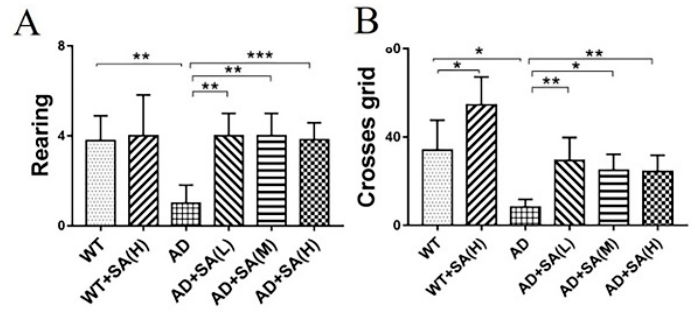
Figure 2. Effect of SA treatment for 4 months on the depression- and anxiety-related behaviors in 2 × Tg AD mice. ( A ) Times of rearing. ( B ) Times of crossing grids (* p < 0.05, ** p < 0.01, and *** p < 0.001). Student’s t test was used for statistical analysis. Error bars represent the mean ± SEM ( n = 12).